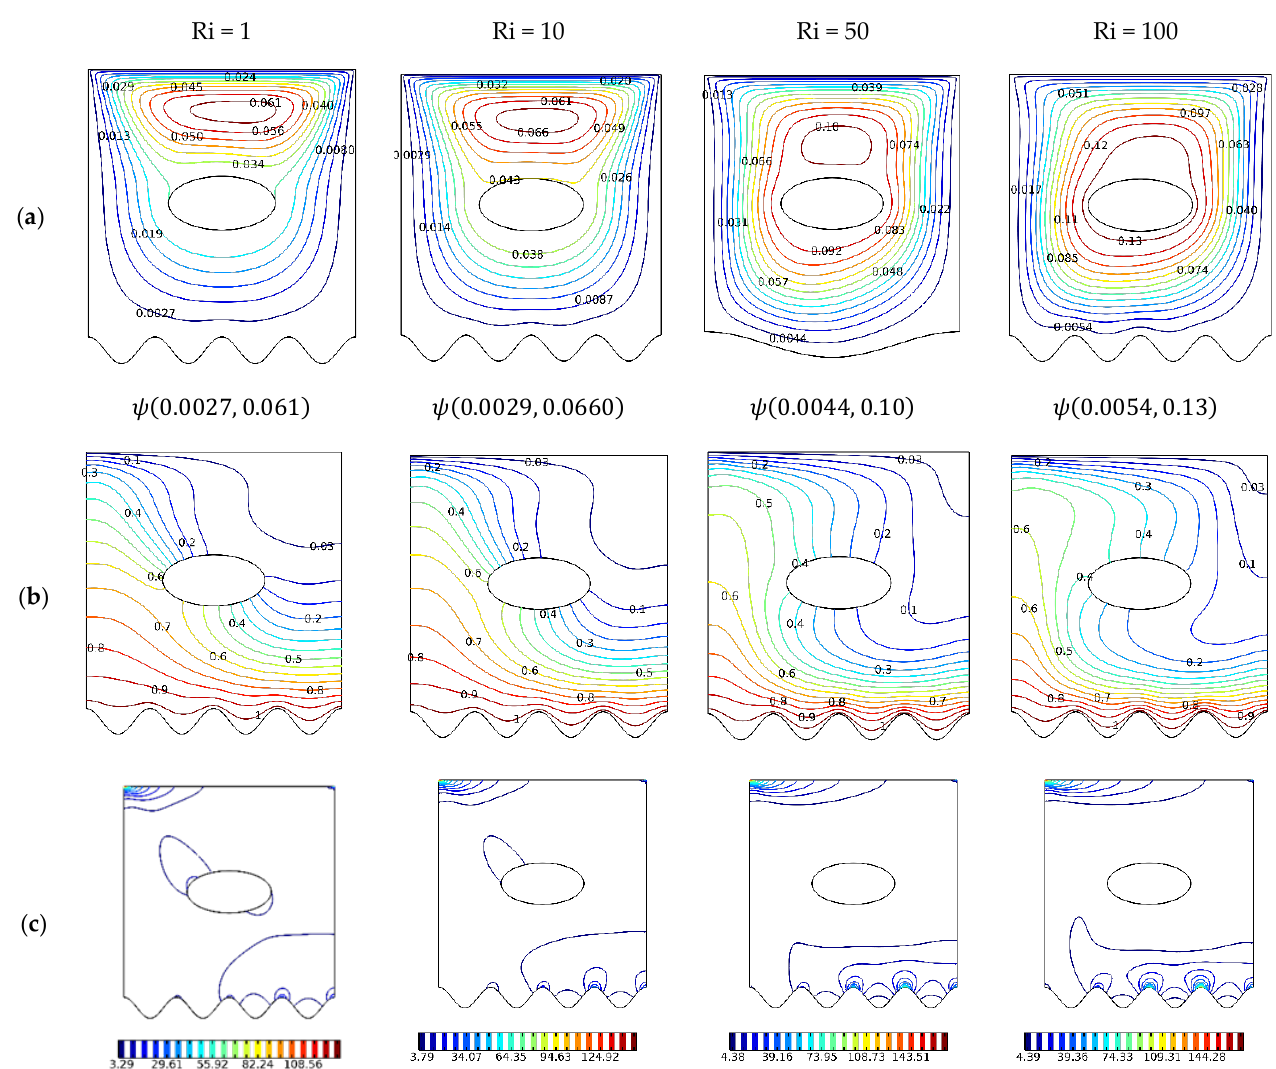
Figure 3. Streamlines, isotherms, and isentropic contours: γ = 0; N = 4; Ha = 0; Ri : 1, 10, 50, 100; ϕ = 0.02. ( a ) ψ ; ( b ) Θ ; and ( c ) S.